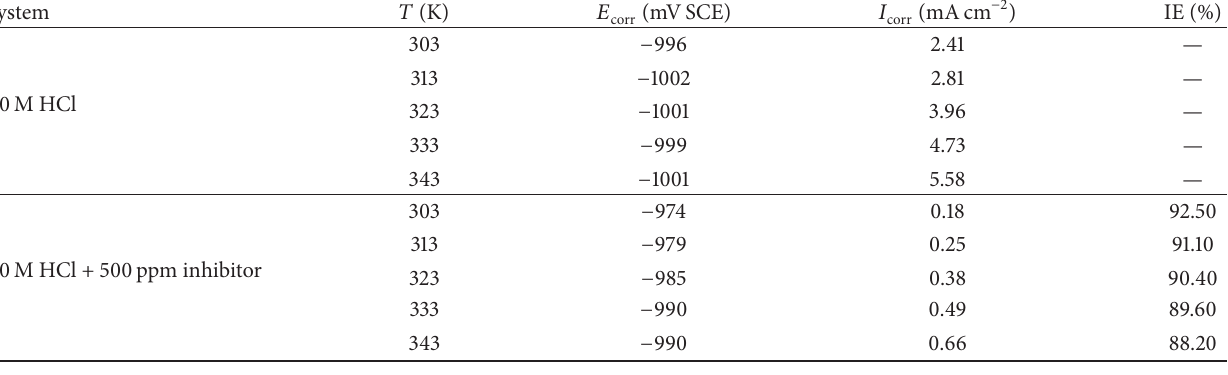
Table 4: Effect of temperature on the corrosion parameters of zinc in 1.0 M HCl and 1.0 M HCl + 500 ppm of marjoram extract. System